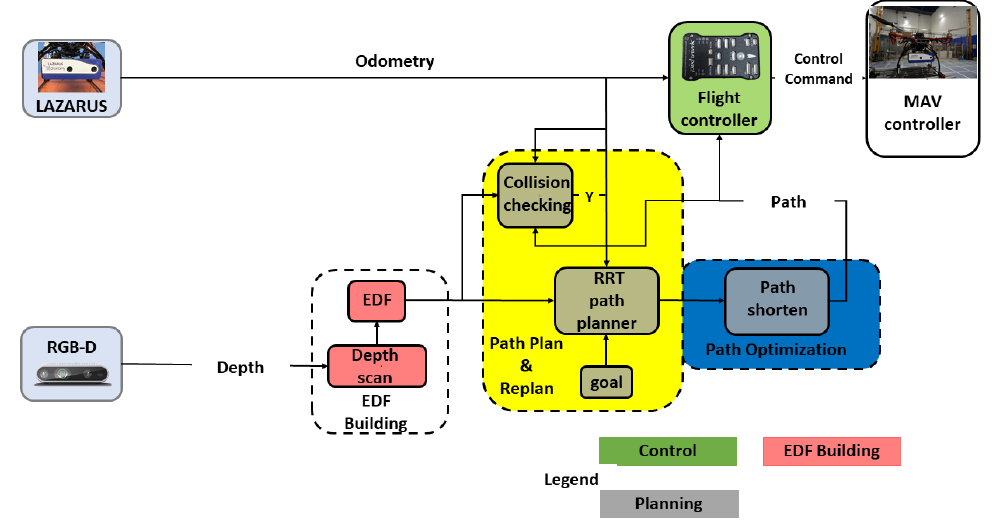
Figure 4. System architecture of the aerial platform used in real flight